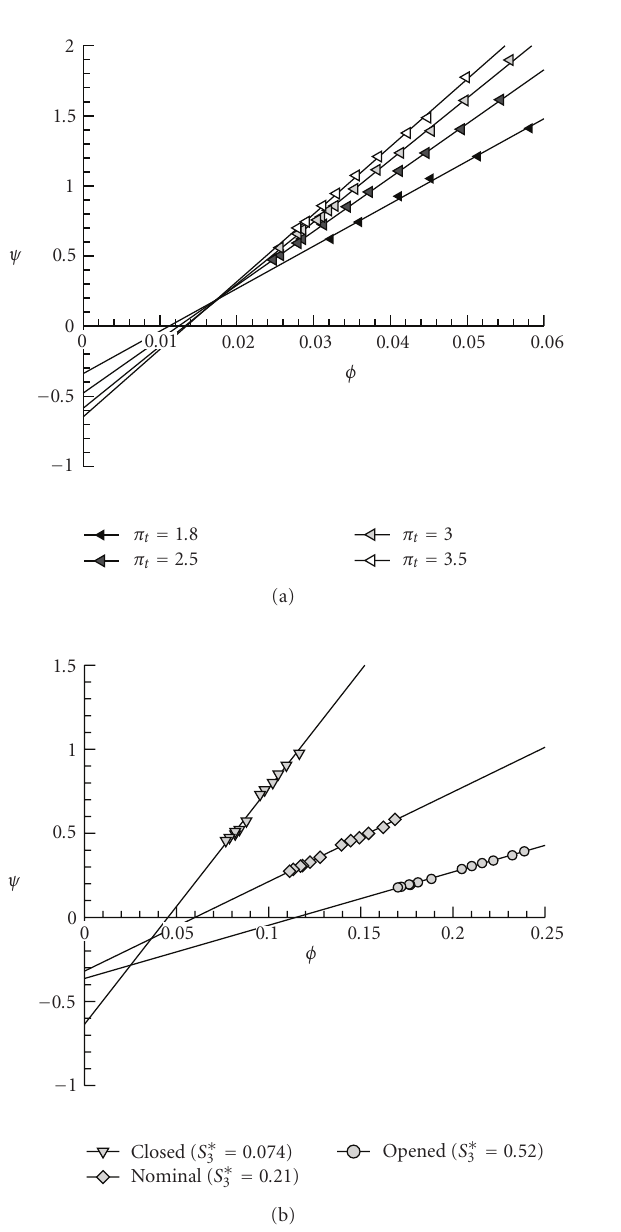
Figure 4: Experimental pressure-ratio line for (a) TS1 and (b) TS2 .